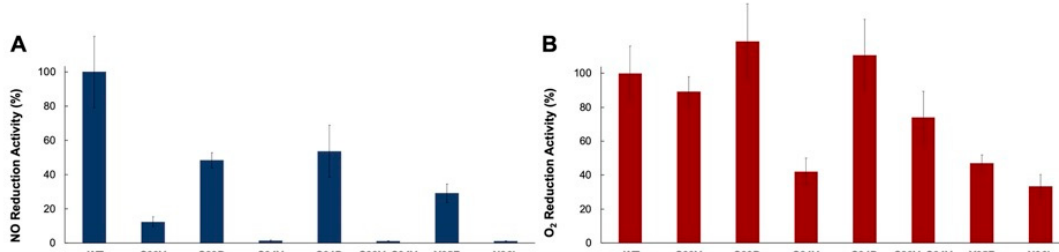
Figure 4. NO and O 2 reduction activities of FDP wt and site-directed mutants. ( A ) NO reductase activities as percentages